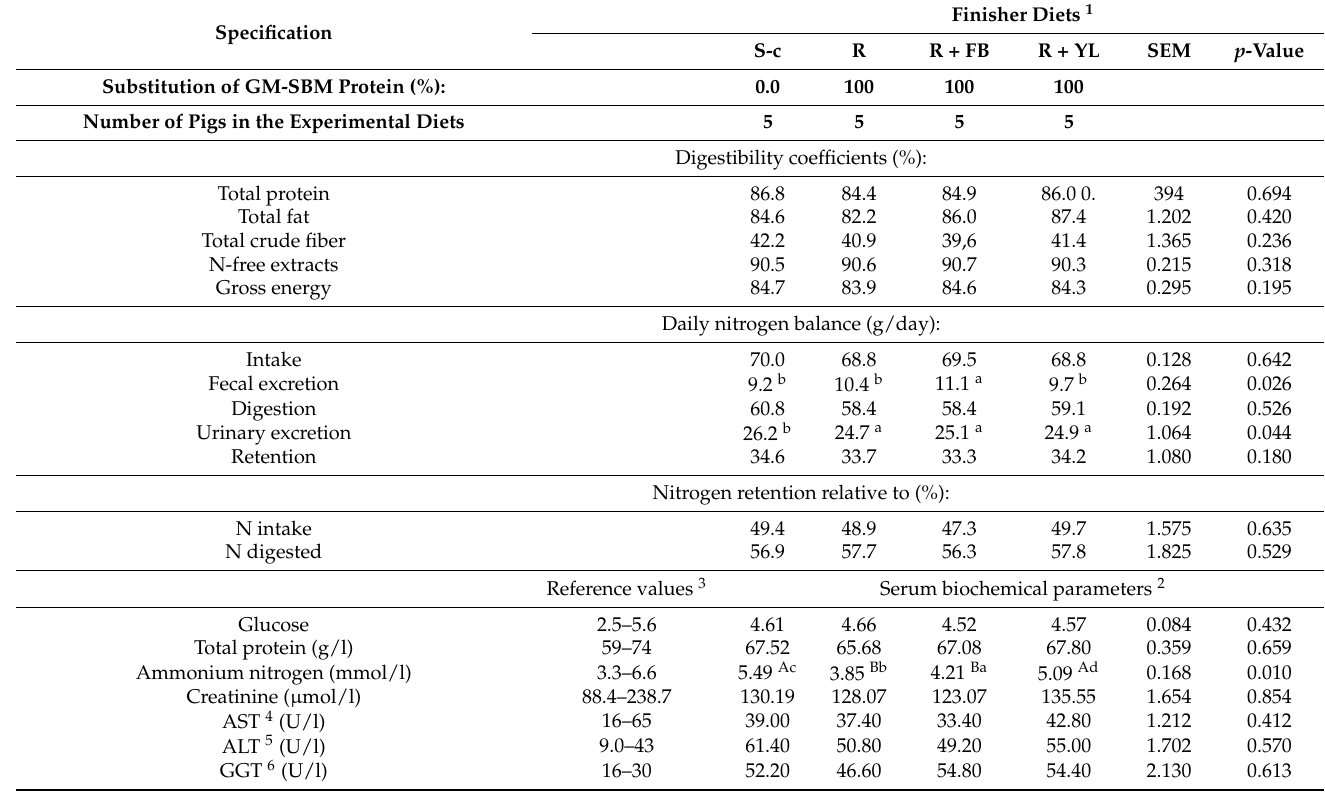
Table 5. Digestibility of nutrients and energy in complete finisher diets, nitrogen balance, and serum biochemical parameters of finishing pigs (Experiment